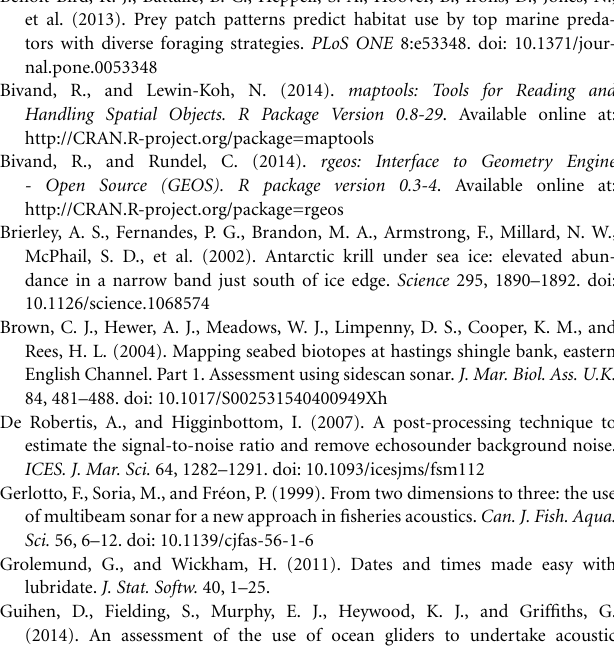
Figure S1 | Screenshot of the Echoview data flow used for the examples. Template made using Echoview